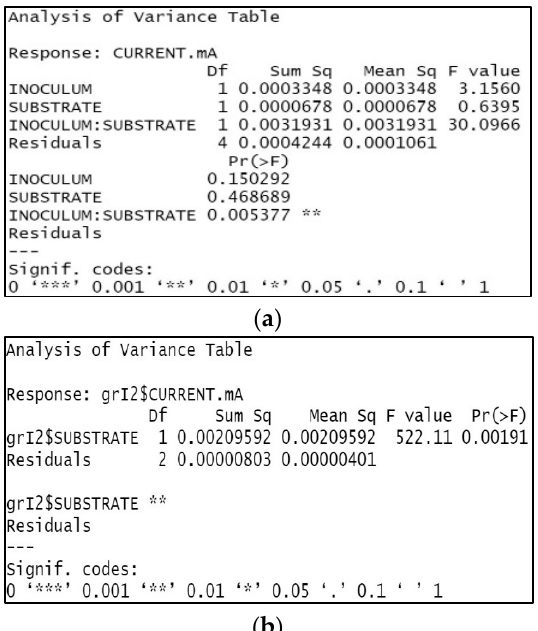
Figure 13. ANOVA analysis of response variable current in experimental design: ( a ) general ANOVA; ( b ) ANOVA fixing the factor maturated inoculum ( I2 ) as group (gr I2 ).